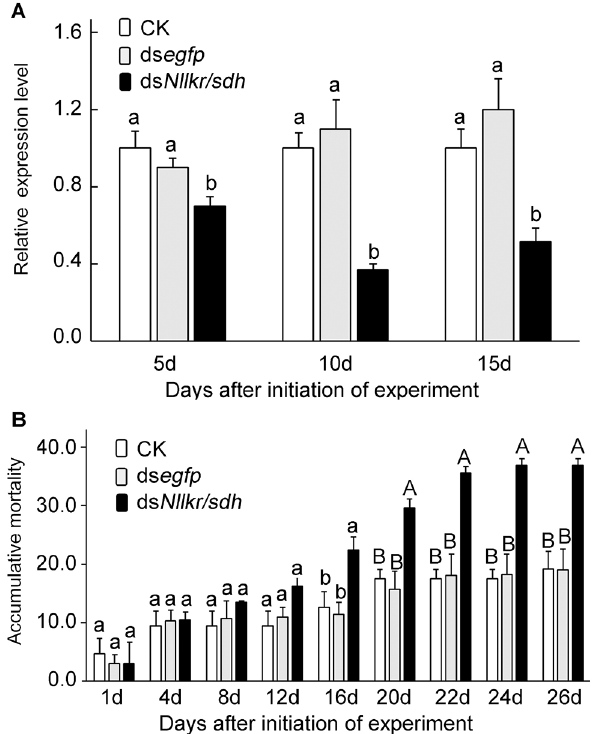
Fig 6. Ingestion of ds Nllkr/sdh on the mRNA level of Nllkr/sdh (A) and the survival (B) of the planthoppers. For the mRNA level, three biological replicates were conducted, and the mean ± SD (n = 3) was calculated to measure the relative transcript levels using the 2 − ΔΔ CT method. For both the mRNA level and accumulative mortality, the columns represent averages with vertical lines indicating SE. Columns that do not share the same letter are significantly different at P value of 0.05.